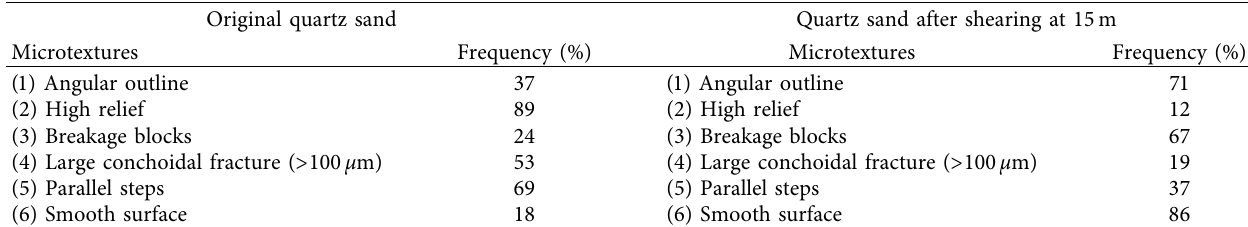
Table 4: Variation of surface texture frequency of the quartz sand